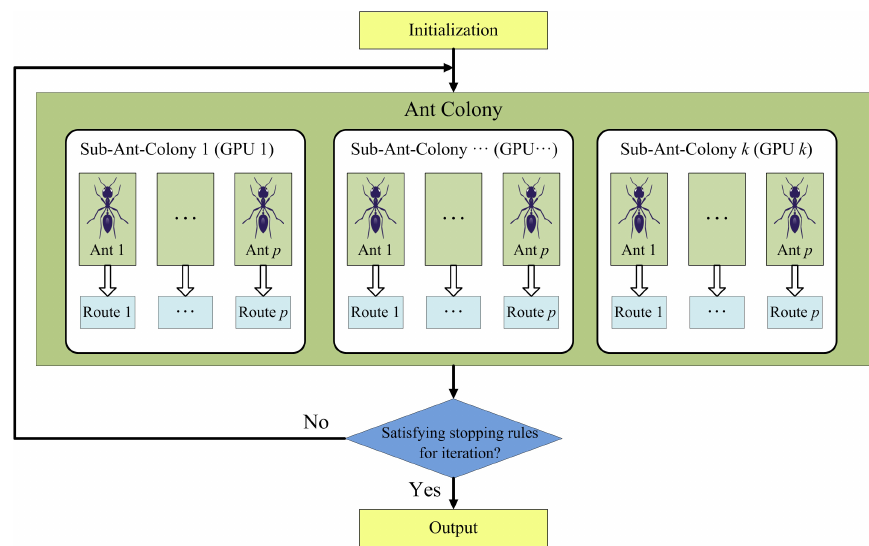
Figure 2. Schematic overview of the parallel design based on multiple